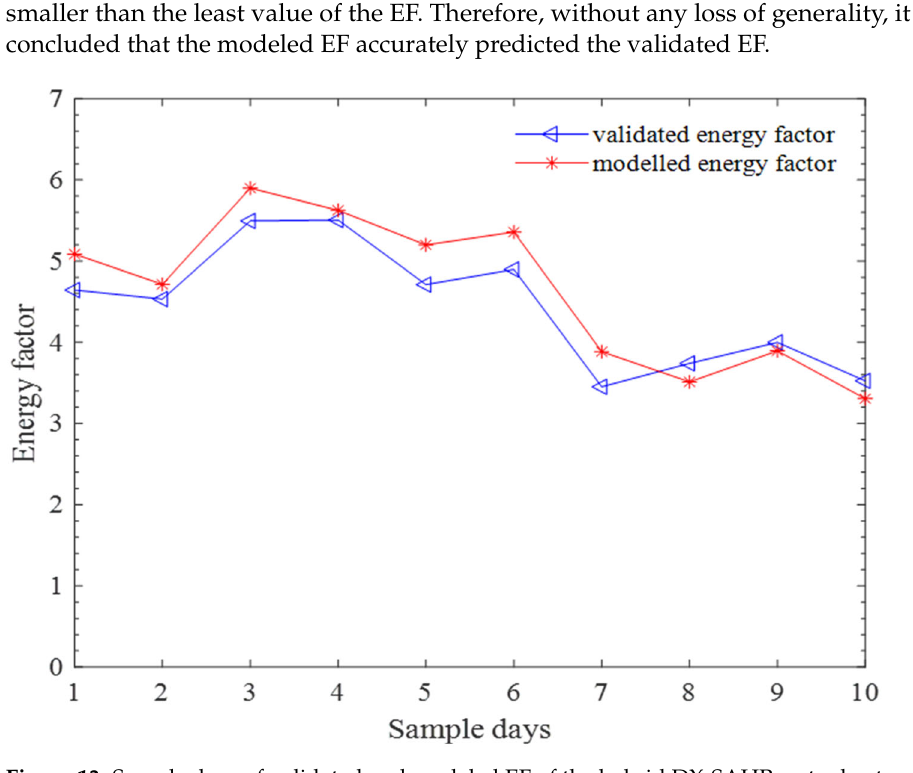
Figure 13. Sample days of validated and modeled EF of the hybrid DX ‐ SAHP water heater.